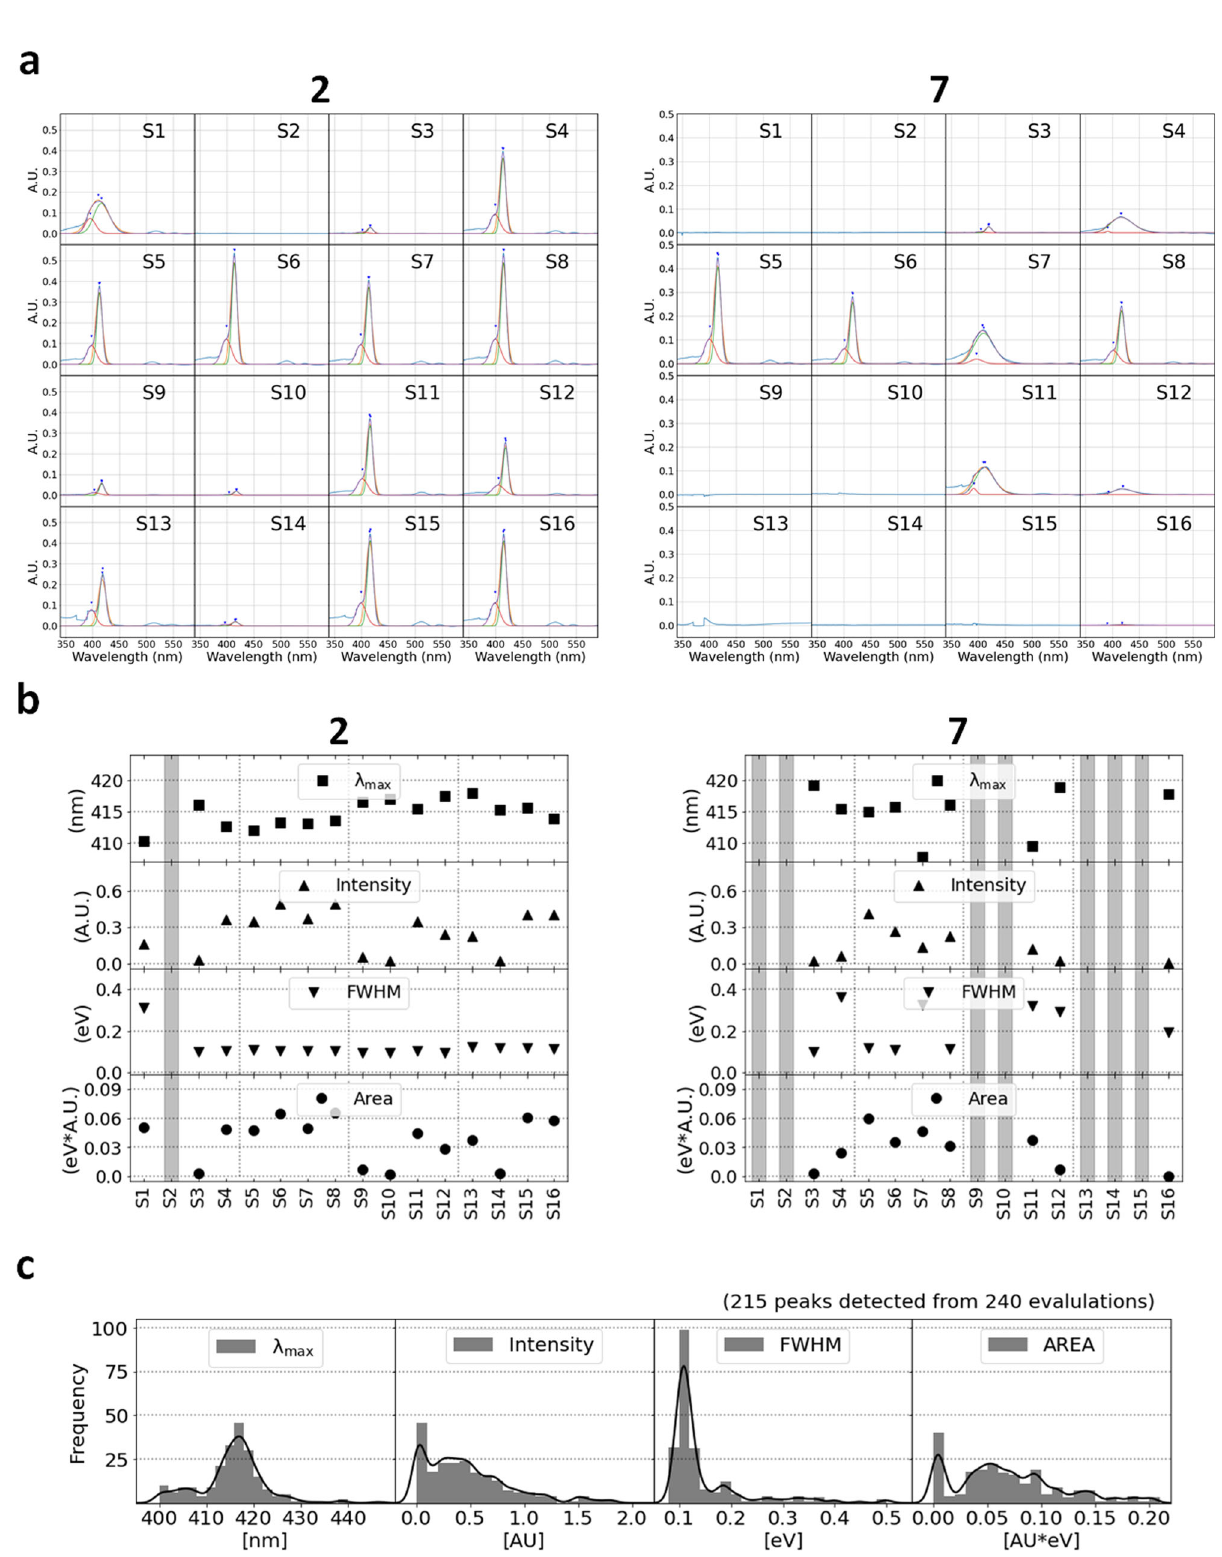
Fig. 5 UV – vis absorption spectra of TPP derivatives in 16 solvents. a Spectra of TPP derivatives 2 and 7 in 16 solvents. The original spectra were plotted in blue lines. Major peaks around 420 nm were fi t using single-Gaussian (orange lines) and two-Gaussian (green and red lines). b Four indicator values ( λ , Intensity, FWHM, and Area) for 2 and 7 were considered from Gaussian- fi ttings. Hatched columns represent cases with no peak detected around max 420 nm. c Histograms of four indicators for all 240 evaluations; main peaks detected for 215 spectra and no main peaks detected for 25